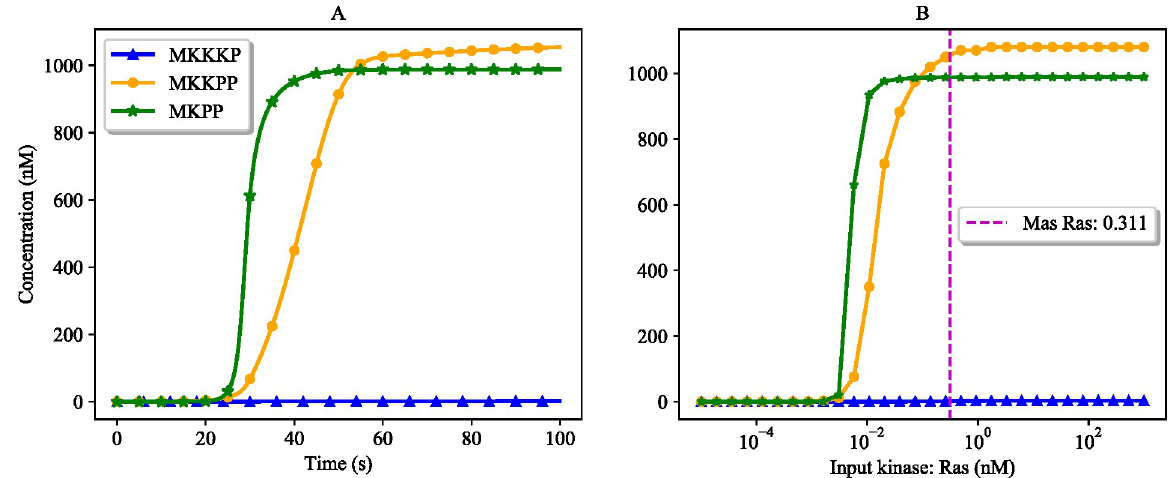
Fig 14. Verification of the responses of activated kinases to Ras in the composed EGFR-Ras-MAPK bond graph model by comparing with the predicted steady-state responses in the MAPK cascade module. (A) Ultrasensitivity in the composed EGFR-Ras-MAPK bond graph model. The steady-state concentrations of the kinases are: MKKKP = 1.37 nM, MKKPP = 1054.37 nM, MKPP = 987.96 nM; (B) Predicted steady-state concentration of the kinases. The purple dashed line shows the concentration of Ras at t = 100 (s) in the composed EGFR-Ras-MAPK bond graph model. The predicted steady-state concentrations of MKKKP, MKKPP, and MKPP at Ras = 0.311 nM match with the ones in the composed EGFR-Ras-MAPK bond graph model.